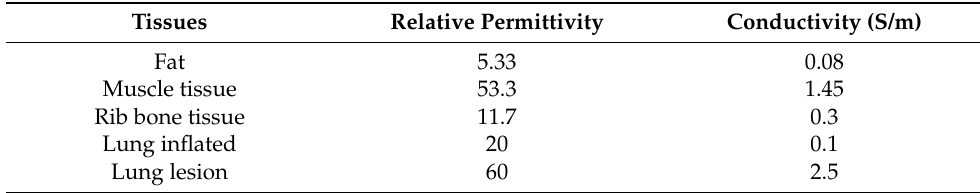
Table 1. Dielectric constant and conductivity at 2 GHz [9,11,18,19].